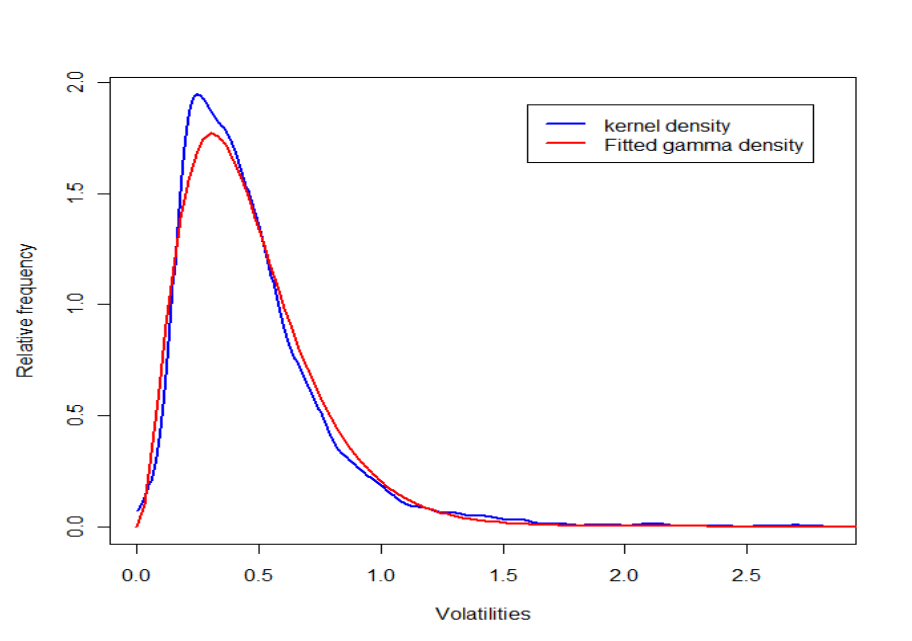
Figure 3. Fitted gamma density and kernel density estimator for volatilities in Figure 1, together with a kernel density